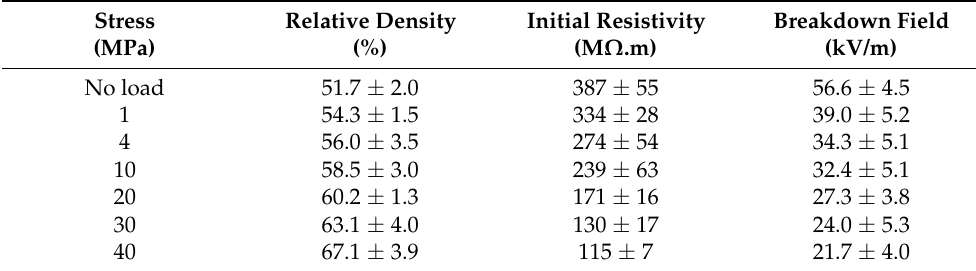
Table 4. Dependence of the relative density, initial resistivity and breakdown field on the pressure applied to the raw powder. Each measurement was repeated five